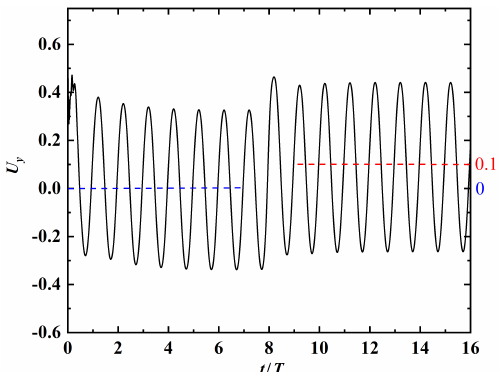
Figure 18. Time history of the leading-edge’s vertical velocity. The blue and red dashed lines denote the time-averaged velocities before and after the turning maneuver.